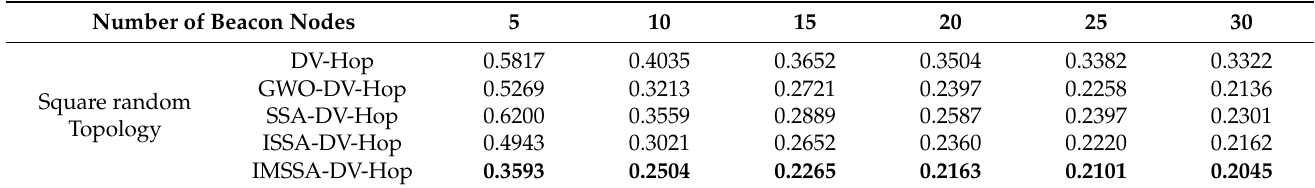
Table 6. Localization error in different number of anchor nodes in square random topology.